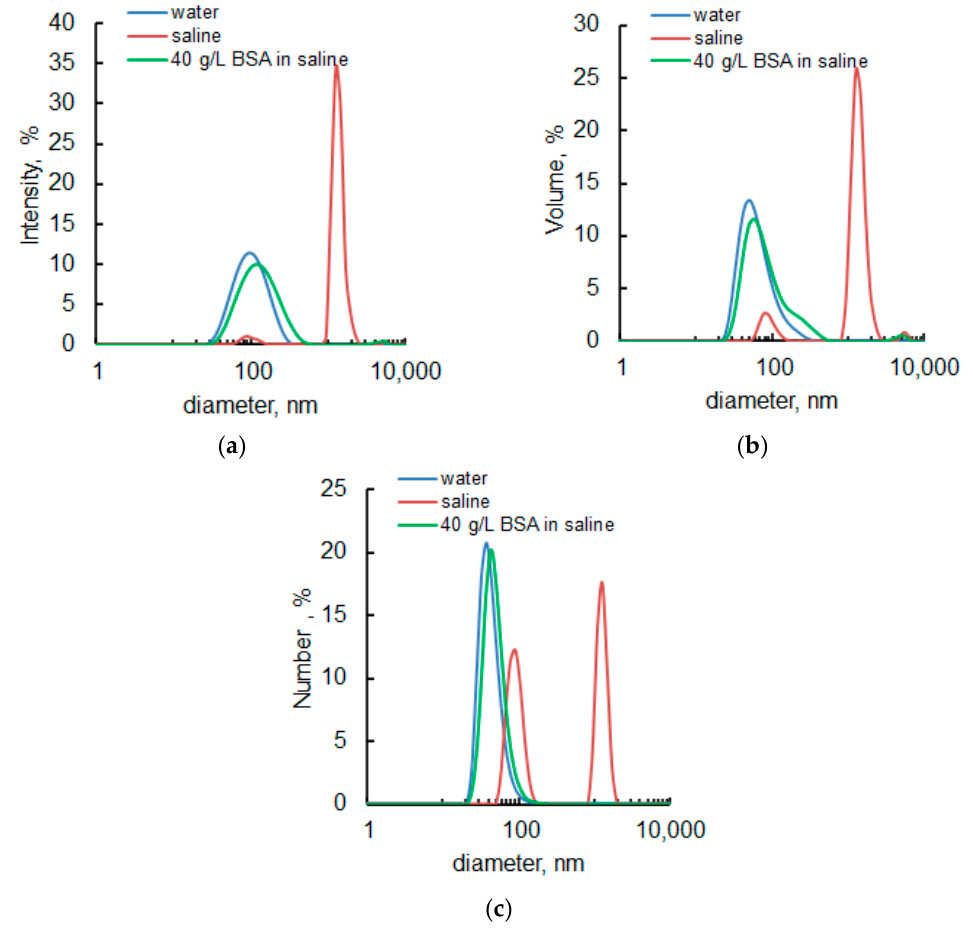
Figure 1. Size distribution of DND particles in the aqueous suspension (blue line), in saline (red line) and in 40 g/L albumin solution in saline according to the dynamic light scattering analysis. ( a ) Distribution by intensity, ( b ) distribution by volume and ( c ) distribution by number.